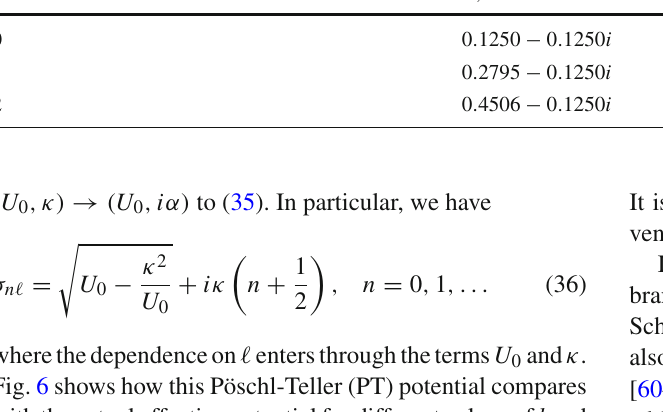
AIM while the third column displays the exact fundamental QNMs computed using formula (52) in